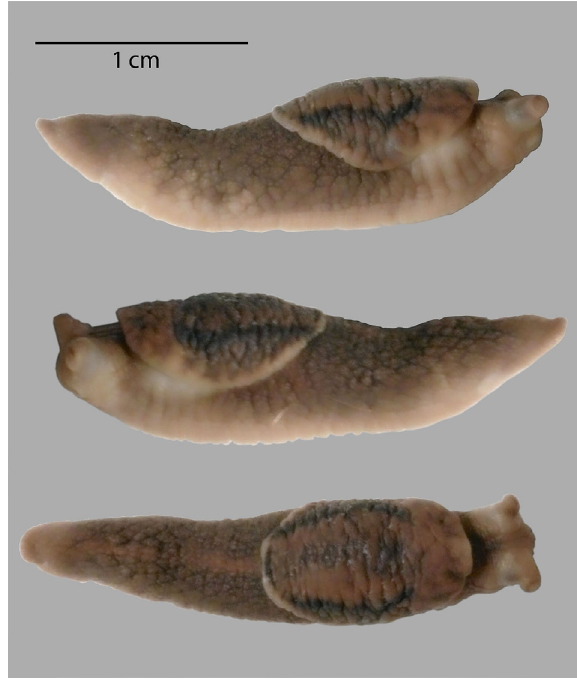
Figure 2. Preserved specimen of P. andersonii from Anse à Wilson, Parc national du Bic, municipalité régionale de comté du Rimouski- Neigette, Quebec, 48.3597°N, 068.7983°W